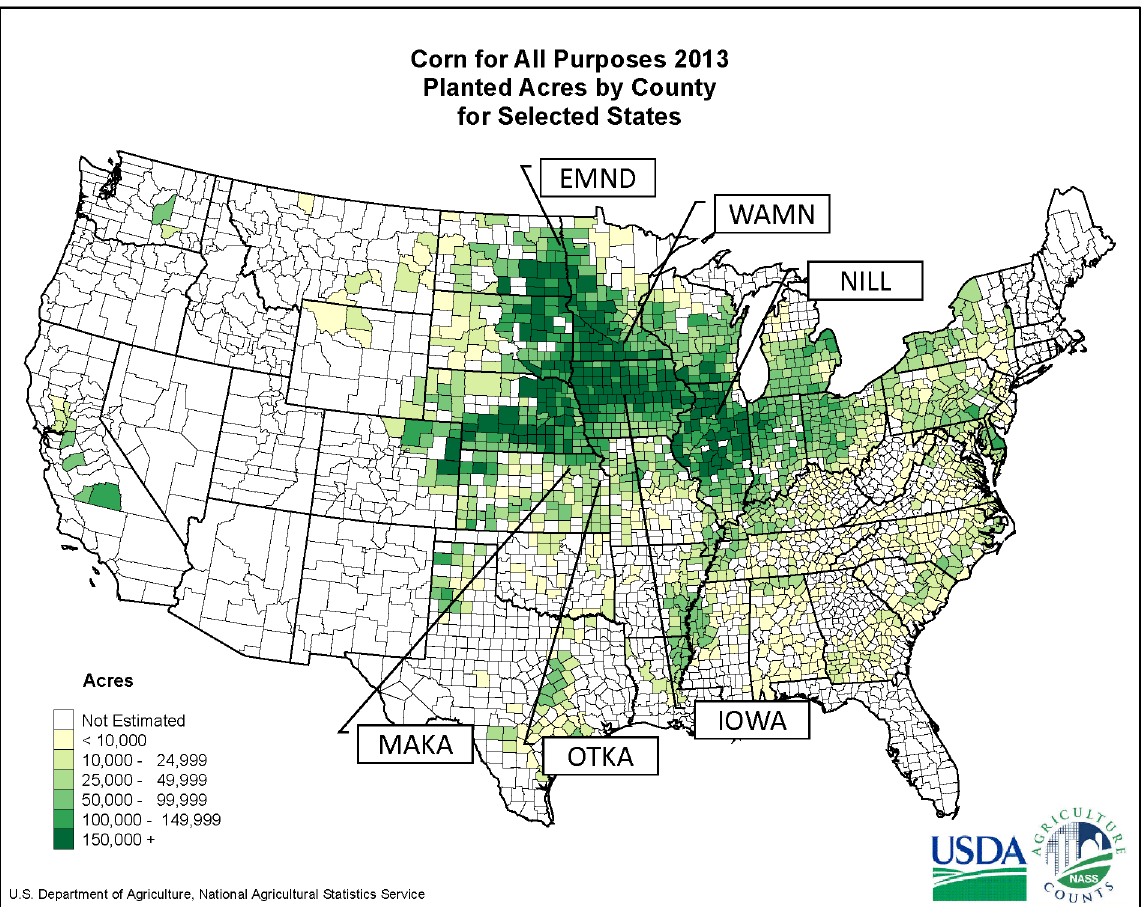
Fig 1. Locations of Peromyscus maniculatus bairdii trapping. The map illustrates the spatial distribution of corn-soybean agricultural intensity in the Midwestern US. The locations indicated on the map are detailed in Table 1. They were chosen because concentrations of historical specimens from before 1910 were available from the region. Three of our locations (NILL, IOWA, and WAMN) are in regions of greater than 75% corn-soybean agriculture cover within the county, while the other three (MAKA, OTKA, and EMND) are in agricultural regions of less than 33% corn and soybean cover within the county.